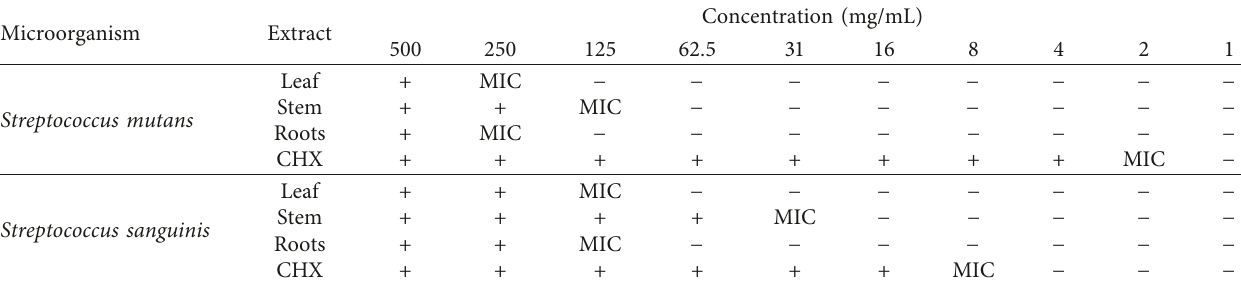
Table 2: Minimum inhibitory concentration according to the methanolic extract of Pelargonium peltatum against strains of Streptococcus mutans (ATCC 25175) and Streptococcus sanguinis (ATCC 10556). Microorganism Extract